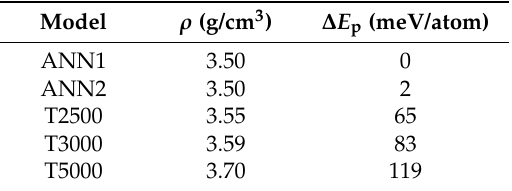
Figure 1. Pair distribution functions for 30Ba of the Si-Ba ( a ) and Gd-Gd ion pairs ( b ) calculated by simulated annealing (ANN1, ANN2) and inherent structure sampling for different temperatures (T2500, T3000, T5000). Table 2. Mass density ρ and relative energies ∆ E p with respect to the lowest energy structure for 30Ba calculated by simulated annealing (ANN1, ANN2) and inherent structure sampling at different sampling temperatures (T2500, T3000, T5000).